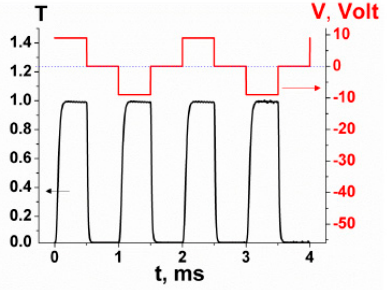
Figure 4. The electrooptic response of the DHF cell, placed between crossed polarizer and analyzer,